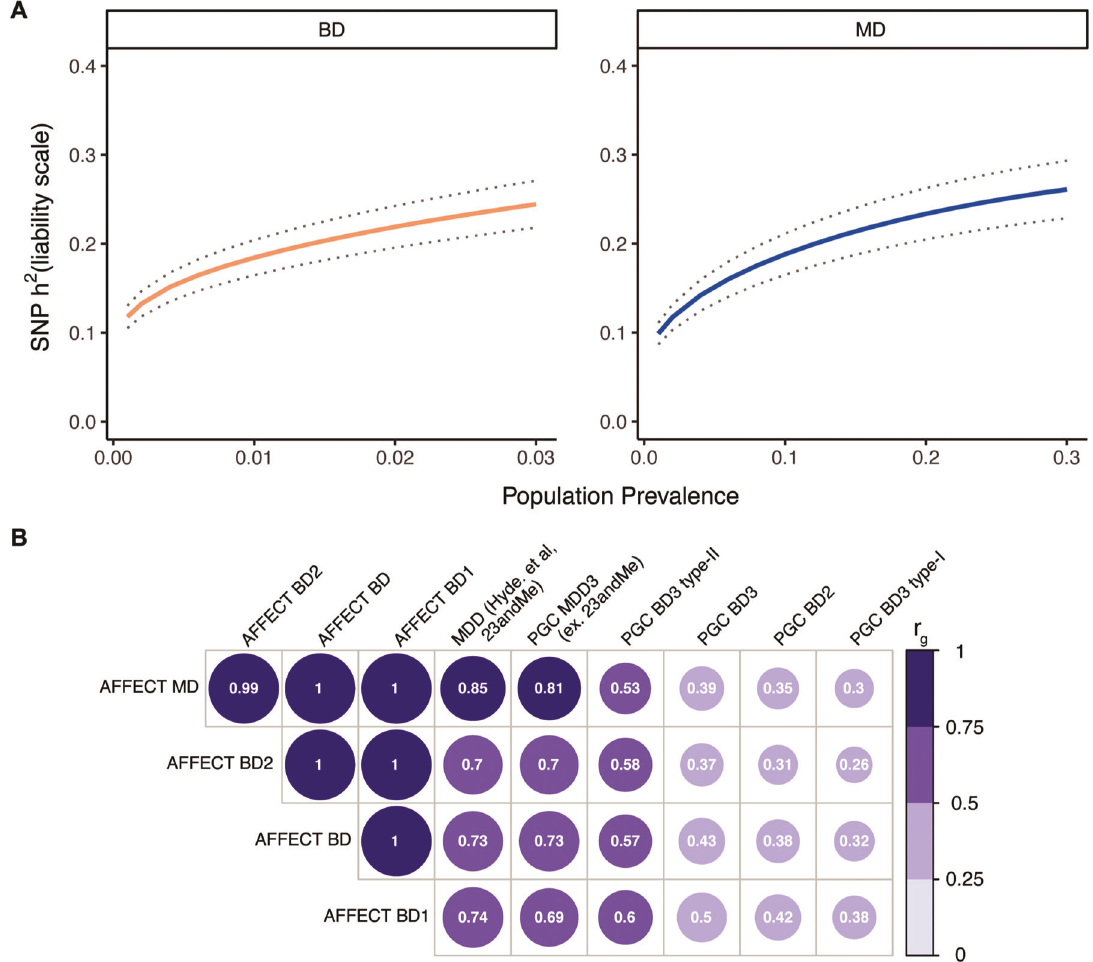
Fig. 3 Genetic component. A Liability-scale SNP-heritability of AFFECT BD and MD as a function of population prevalence, ranging from 0.001 to 0.03 for BD and 0.001 – 0.3 for MD with r g estimates at every 0.001 step-wise increase. Dotted line represents s.e. B Estimated genetic correlations of European ancestry AFFECT BD and MD with PGC GWAS of MDD3 (excluding the 23andMe cohort), the 23andMe MD discovery cohort (Hyde et al, 2016), PGC-BD2, and of PGC-BD3, which is further divided into BD3 type I and type II. Correlations in AFFECT BD were performed with the full cohort (BD) and within BD type (BD1, BD2). All correlations were signi fi cant, circle size and values indicate r g . P -values, Z -scores and s.e are reported in Supplementary Table